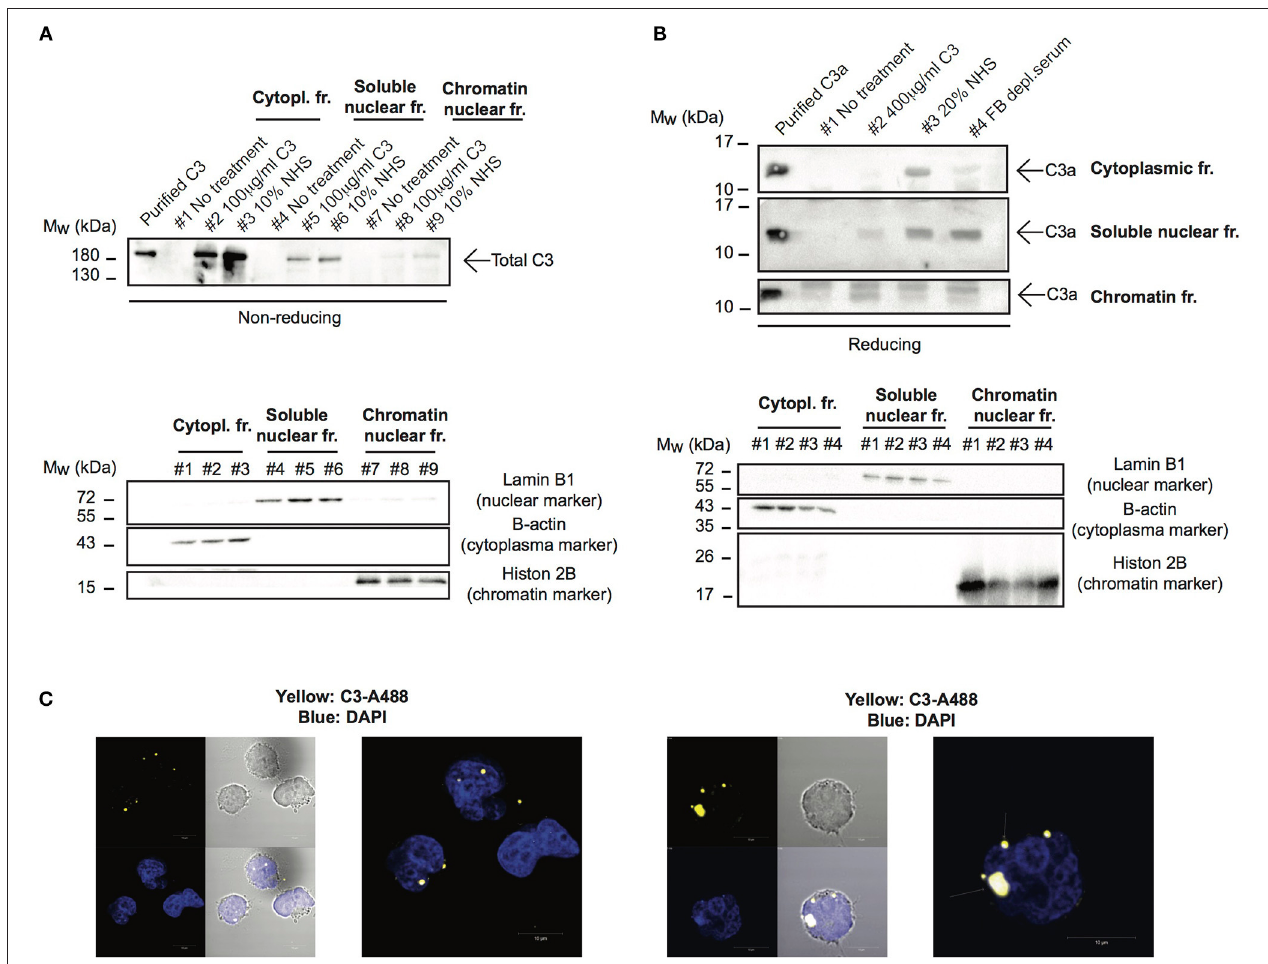
FIGURE 4 | C3 and C3a enter the nucleus after uptake. (A,B) Western blot results showing presence of C3 and C3a in nuclear compartments of Raji cells. The human B cell line, Raji was incubated with NHS, C3 or C3met as a source of C3 either in EDTA-GVB (A) or in Mg-EGTA (B) buffer for 1h at 37 ◦ C. After lysis, cytoplasmic, soluble nuclear, and chromatin-associated nuclear fractions were separated and analyzed by Western blot with the goat polyclonal anti-C3 antibody under non reducing conditions (A) or with the rabbit polyclonal antibody against C3a under reducing condition (B) . The purity of distinct cellular fractions was verified using antibodies against B-actin (cytoplasmic marker), lamin B1 (nuclear marker) and histone H2B (chromatin-associated nuclear marker). Results shown are one representative experiment out of three (A) or four (B) independent analyzes. (C) Representative confocal images showing that AlexaFluor 488 labeled C3 enters the nucleus. 2 × 10 6 Raji cells were incubated with 100 µ g/ml C3-AlexaFluor 488 for 30min at 37 ◦ C, fixed and counterstained with DAPI using mounting medium. Representative images are shown from two independent experiments investigating at least 50